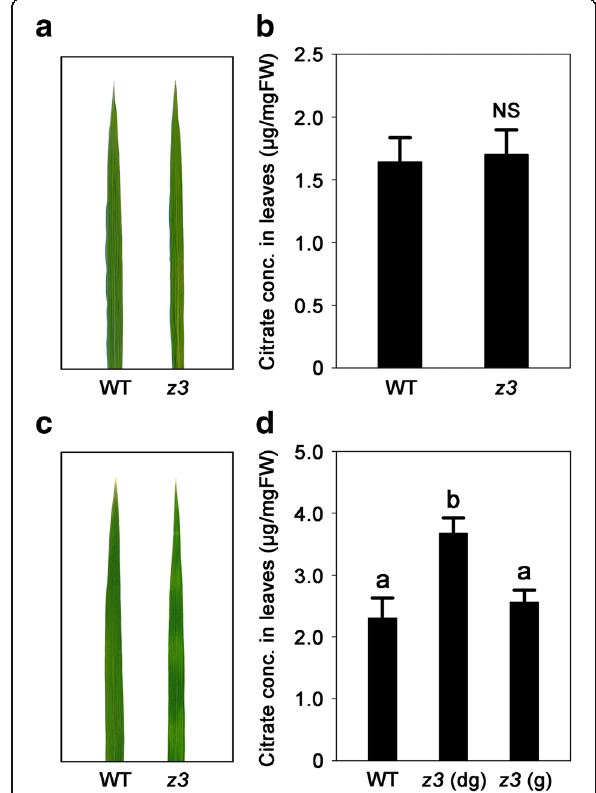
Fig. 7 Citrate concentrations in the leaves of the z3 mutant. a, c The second leaves of 90-day-old ( a ) and 117-day-old ( c ) WT and the z3 mutant grown in a natural paddy field. b, d Citrate concentrations in the second leaves of the WT and the z3 mutant at 90 DAS ( b ) and 117 DAS ( d ) grown under natural long day conditions. Citrate concentrations were determined with HPLC. Data are means ± SD ( n = 4). Different letters indicate a significant difference at P < 0.01 (Duncan ’ s test). Abbreviations: WT, wild type; z3 (dg), dark-green sectors of the z3 mutant leaves; z3 (g), green sectors of the z3 mutant leaves; FW, fresh weight; NS, not significant; conc.,